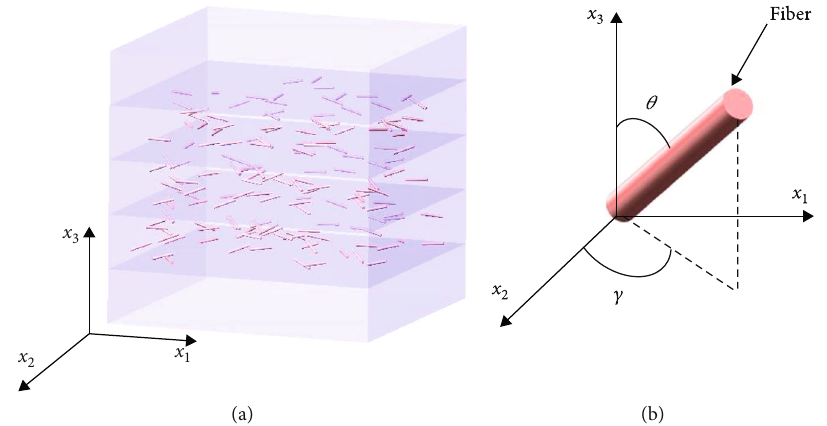
Figure 1: Three-dimension image of the SMPC. (a) SMPC reinforced with short fi bers. (b) Short fi ber direction.